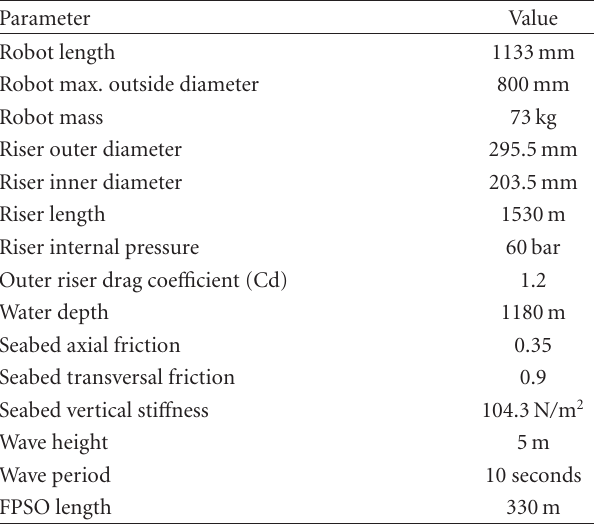
Table 1: Parameters used in the